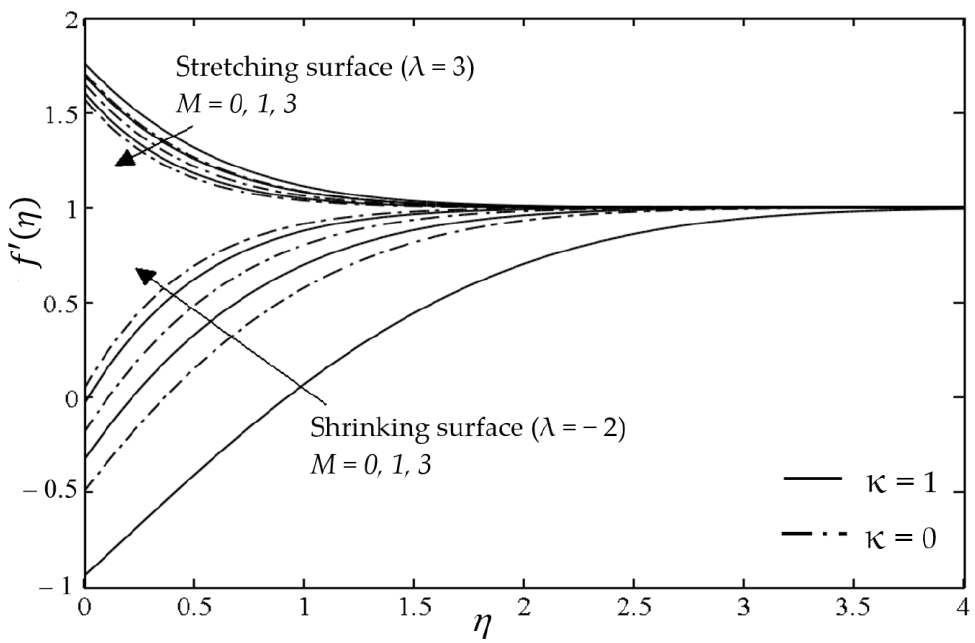
Figure 5. Impact of the magnetic parameter, M , on the velocity profiles for different κ and λ . The dimensionless heat transfer coefficient, Nu x Re − 1/2